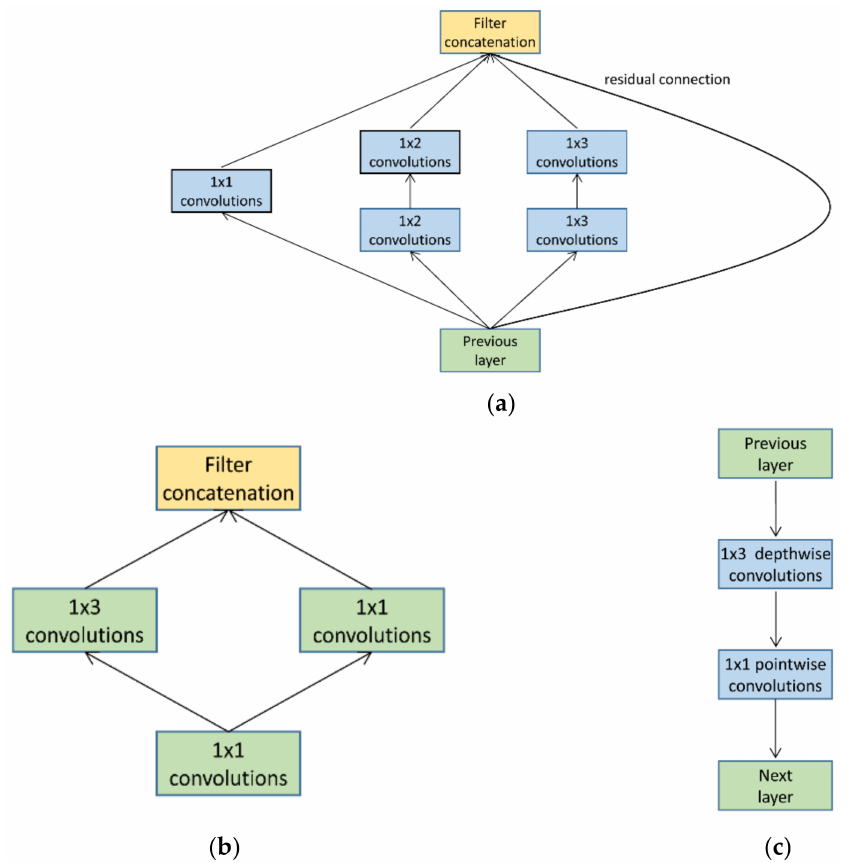
Figure 1. ( a ) Inception module; ( b ) Fire module; ( c ) Depthwise separable convolution that factorizes a standard convolution into a depthwise convolution and a pointwise convolution.